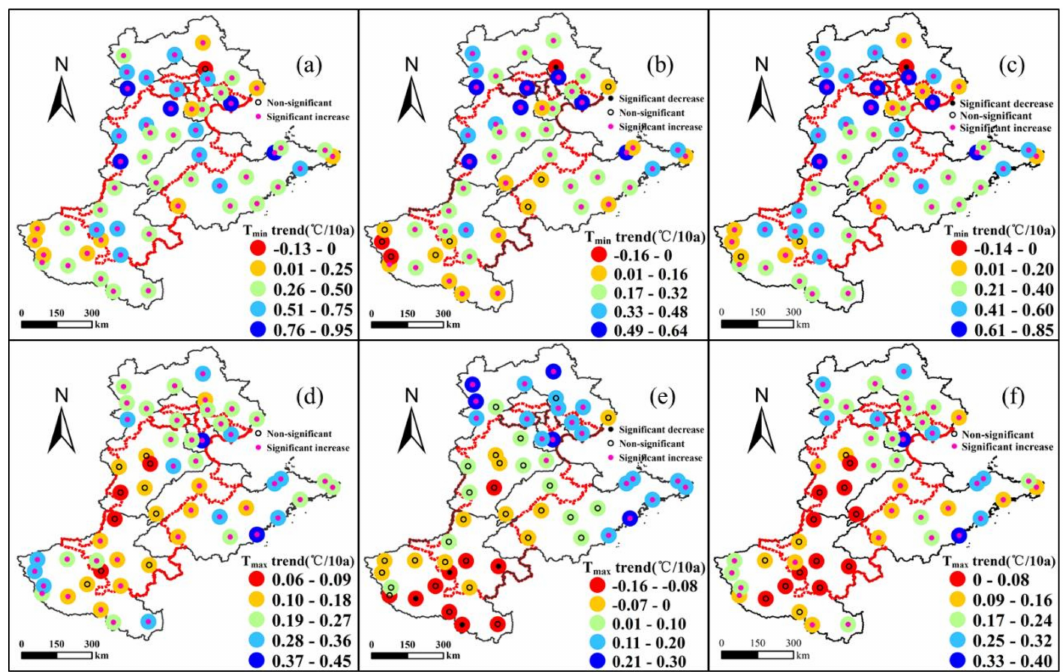
Figure 3. The spatial distribution and statistical significance of the trends in ( a – c ) T min and ( d – f ) T max on the winter-wheat growing-season, the summer-maize growing-season, and the annual